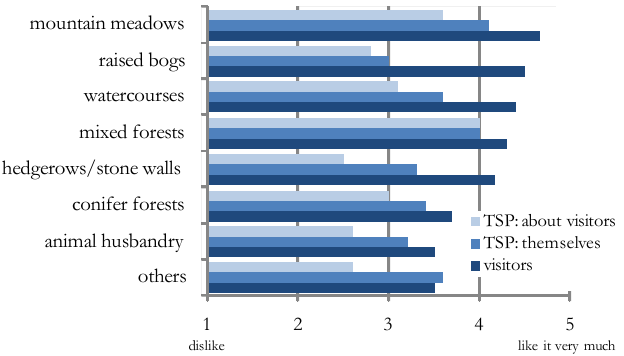
Figure 5: Valuation of different landscape elements in the Eastern Ore Mountains by visitors (visitors n=308; TSP n=66 average values; 5: like it very much; 1: